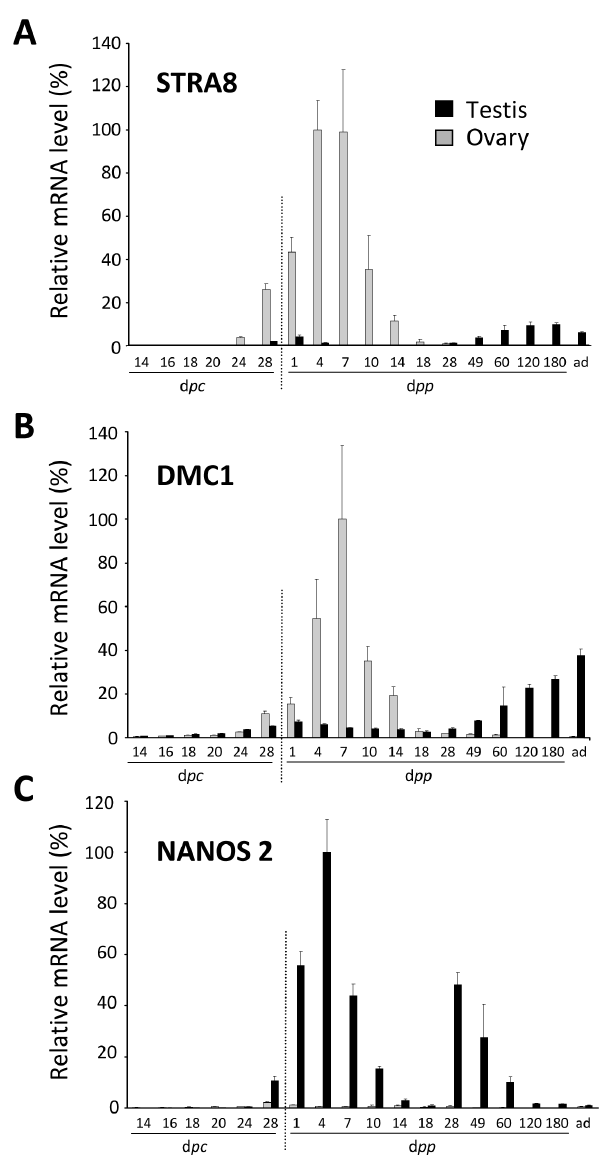
Figure 6. Expression of genes involved in meiosis. Expression levels of the STRA8 , DMC1 and NANOS2 genes were determined in male and female gonads. Values are given as percentages after normalisation to the highest value (100%). Note that at 120 and 180 d pp , only male samples were collected.